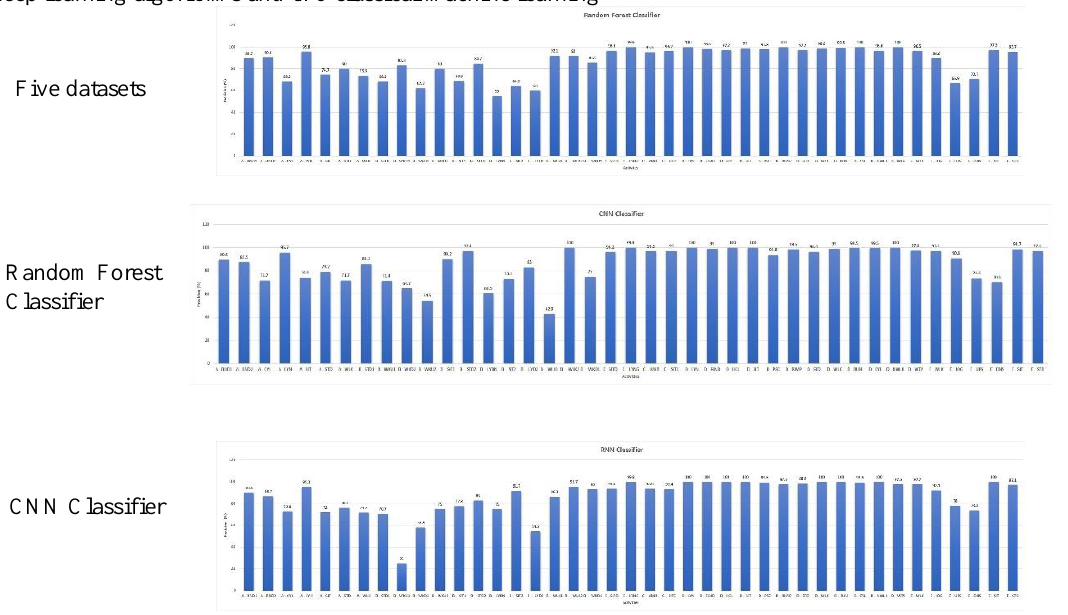
Figure 3. Comparison analysis for precision of random forest classifier, All Activities of all five dataset can be visualized. Each activity is represented as <Dataset Representation >- <Activity abbreviation denoted in table 2 >. A represents AReM dataset, B represents HAPT dataset, OLDPPL is represented by C,D represents PAMAP2 dataset and E represents WISDM